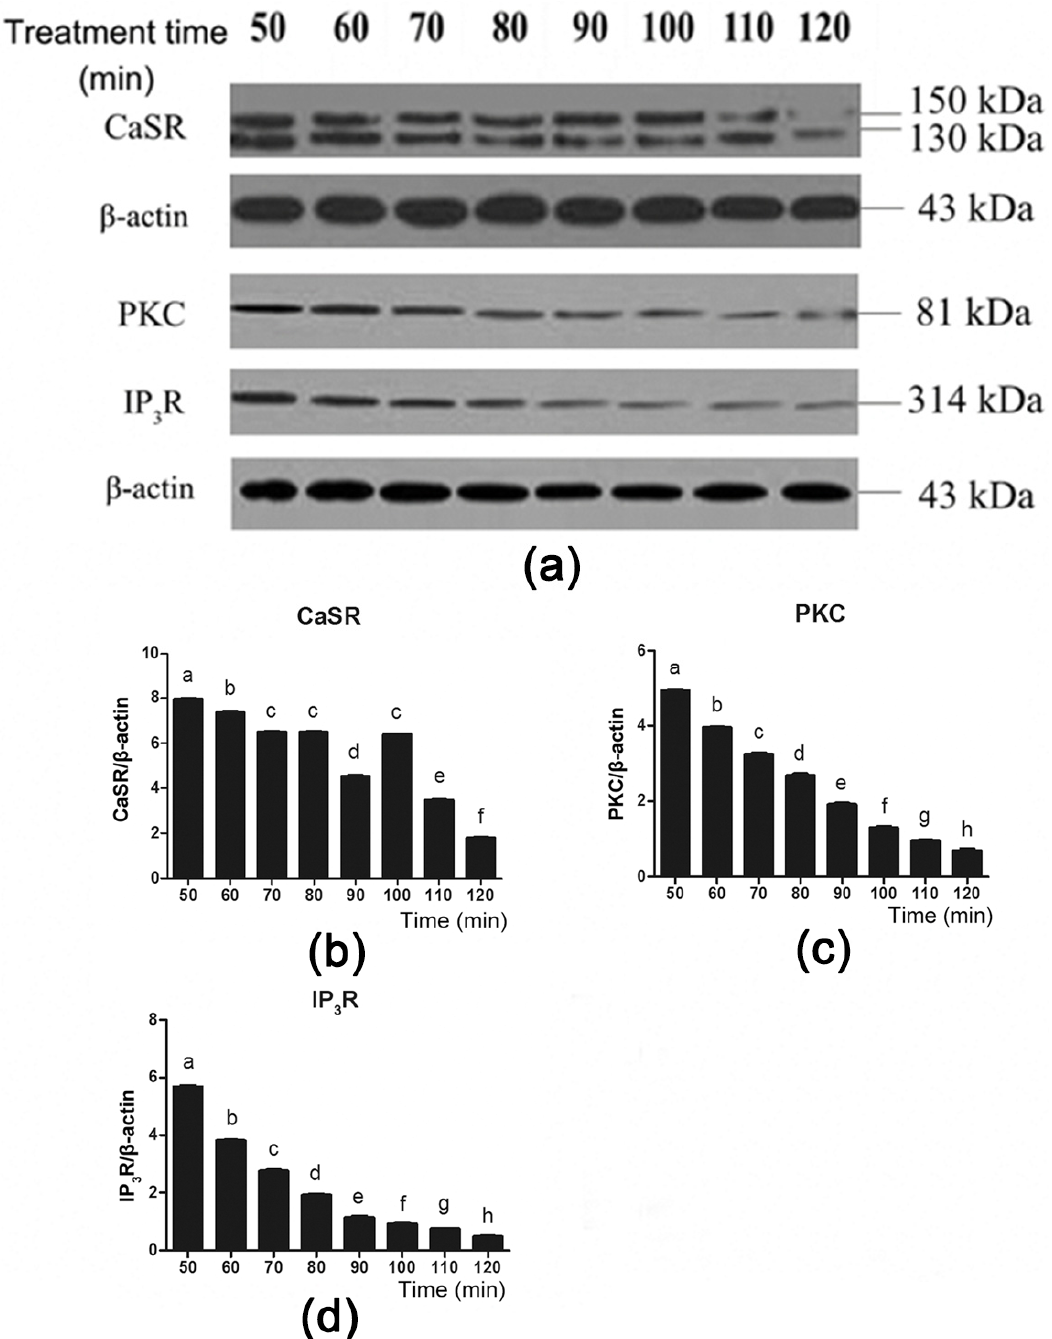
Figure 6. Effect of the CaSR antagonist NPS 2143 on the CaSR-mediated downstream pathway in the presence of 80 mM Phe in pig duodenum. The tissues were perfused with 80 mM Phe and 25 µM NPS 2143 (specific CaSR antagonist) for 160 min. During the perfusion, the perfused tissues were recovered every 10 min, starting from 50 min to 120 min, to extract total protein. ( a ) The measurement of protein levels of ( b ) CaSR, ( c ) PKC, and ( d ) IP 3 R in the duodenum tissues was performed by western blot analysis, using β -actin as a loading control. Data are expressed as mean ± SEM ( n = 3). Dissimilar letters represent a significant difference at p < 0.05.